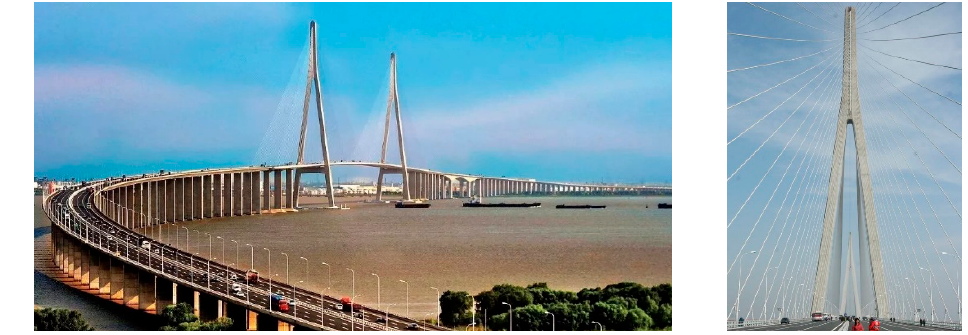
Figure 11. Overview of the experimental bridge.